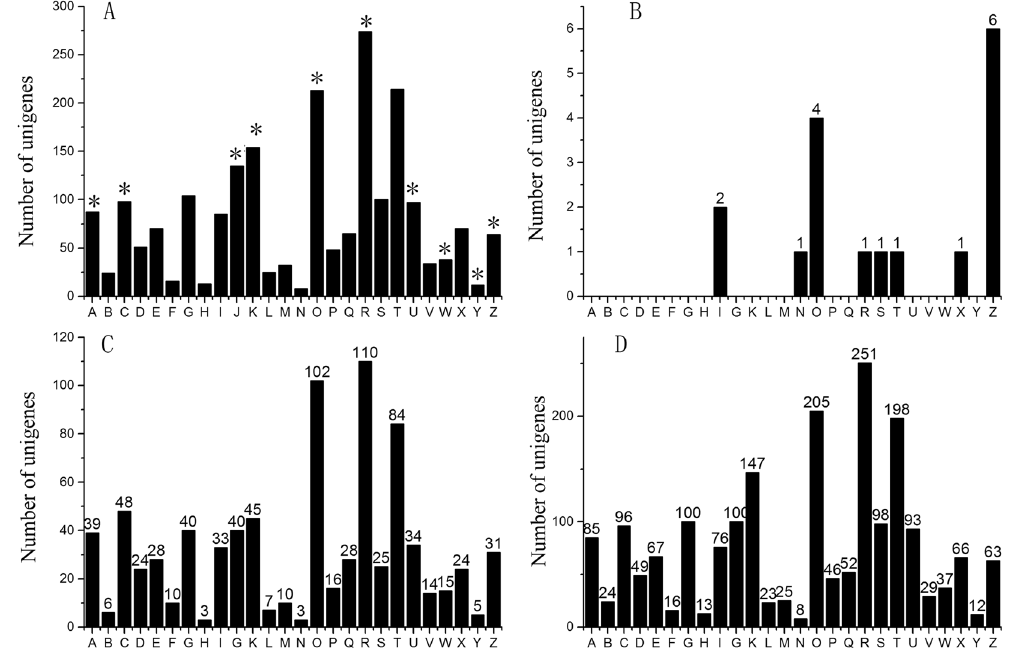
Figure 4. The KOG analysis of DEUs of 3d, 14d and 28d treatments. The x-axis indicates the different subcategories of KOG analysis, and the upper cases of x-axis are the abbreviations of their corresponding subcategories, which are showed in Supplementary Table S2. Y-axis indicates the gene number of each subcategories. The numbers on each column represent the gene number of the subcategories. ( A ) The KOG analysis of all DEUs. The “ * ” represent the enriched subcategories. ( B ) The KOG analysis for the DEUs of 3d treatment. ( C ) The KOG analysis for the DEUs of 14d treatment. ( D ) The KOG analysis for the DEUs of 28d